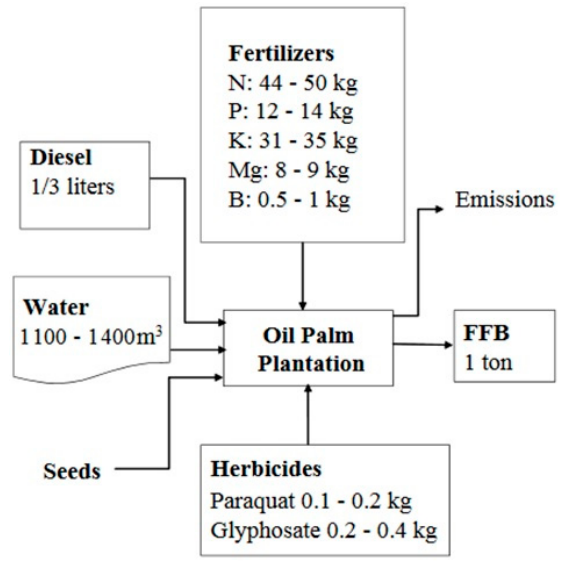
Figure 1. Unit process of a palm oil plantation (FFB—fresh fruit bunch).